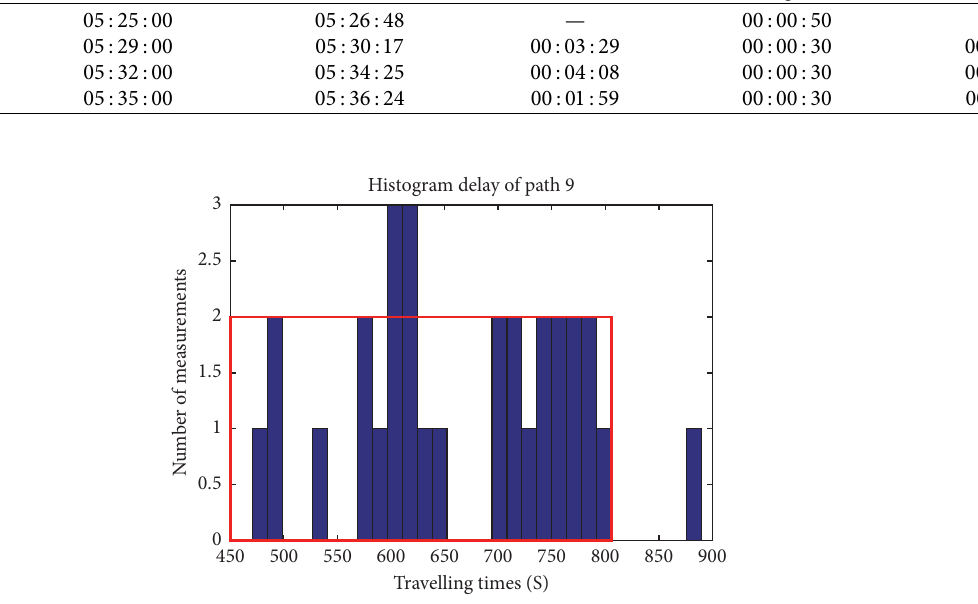
Figure 6: Uniform PDF of the travelling time between the Faculty to Monastir stations (Sousse to Mahdia direction).